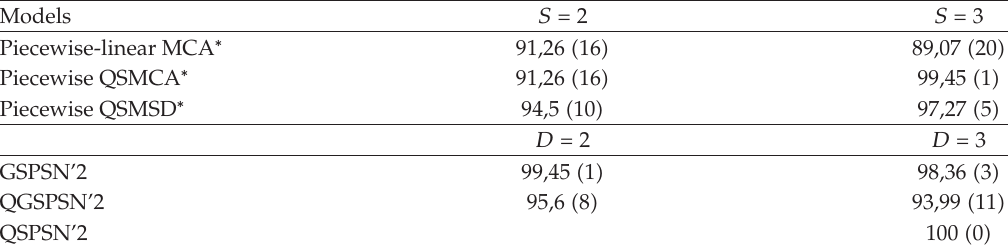
Table 10: The holdout sample hit rate (cid:2) in percentage (cid:3) of dataset